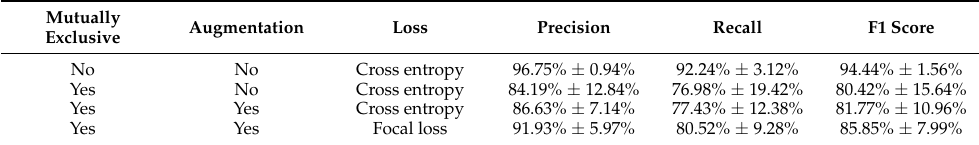
Table 5. Performance of the Experiment 1 and Experiment 2A–C of sex recognition.